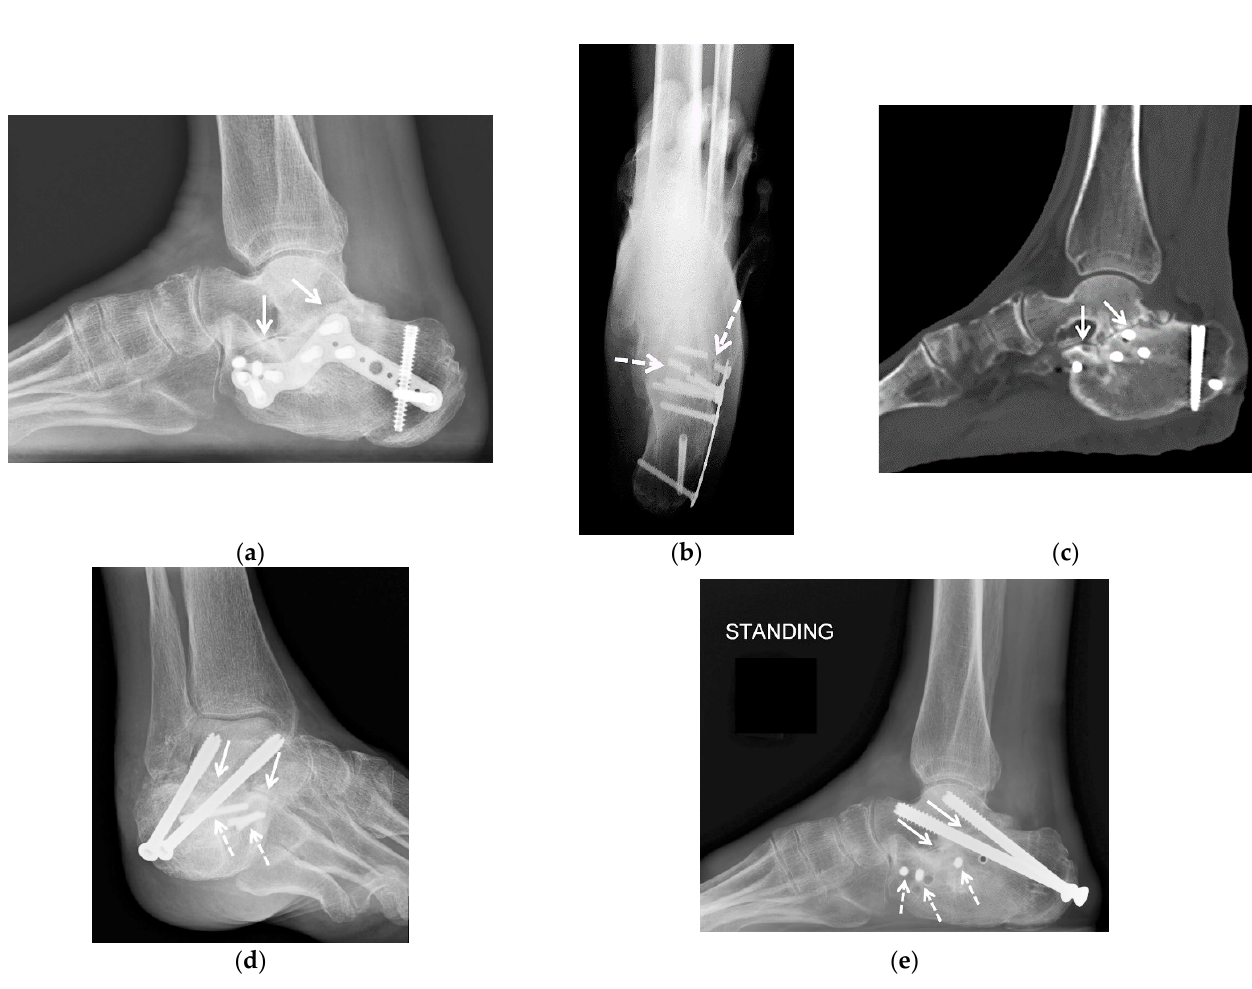
Figure 5. ( a – c ) A 67-year-old female with a history of remote comminuted right calcaneus fracture treated with plate and screws fixation with subsequent hardware fracture and subtalar osteoarthritis with subfibular impingement treated with calcaneal hardware removal, calcaneal exosteoectomy and subtalar arthrodesis with cellular allograft. ( a ) Lateral weight-bearing radiograph of the right foot shows a healed calcaneus fracture status post plate and screws fixation. Note marked asymmetric narrowing of the subtalar joint consistent with advanced posttraumatic osteoarthritis (white arrows). ( b ) On the axial Harris weight-bearing radiograph note fracture of multiple fixation screws (dashed white arrows). ( c ) Sagittal reformatted CT image shows advanced posttraumatic osteoarthritis of the subtalar joint with asymmetric joint space narrowing, scattered subchondral sclerosis and cyst-like changes. ( d ) Broden and ( e ) lateral radiographs obtained 2.5 months after subtalar arthrodesis show interval removal of the calcaneal plate and multiple screws with three broken screw fragments remaining (white dashed arrows). Note two retrograde partially threaded cannulated screws transfixing the subtalar joint (white arrows) with early fusion about the fixation screws.